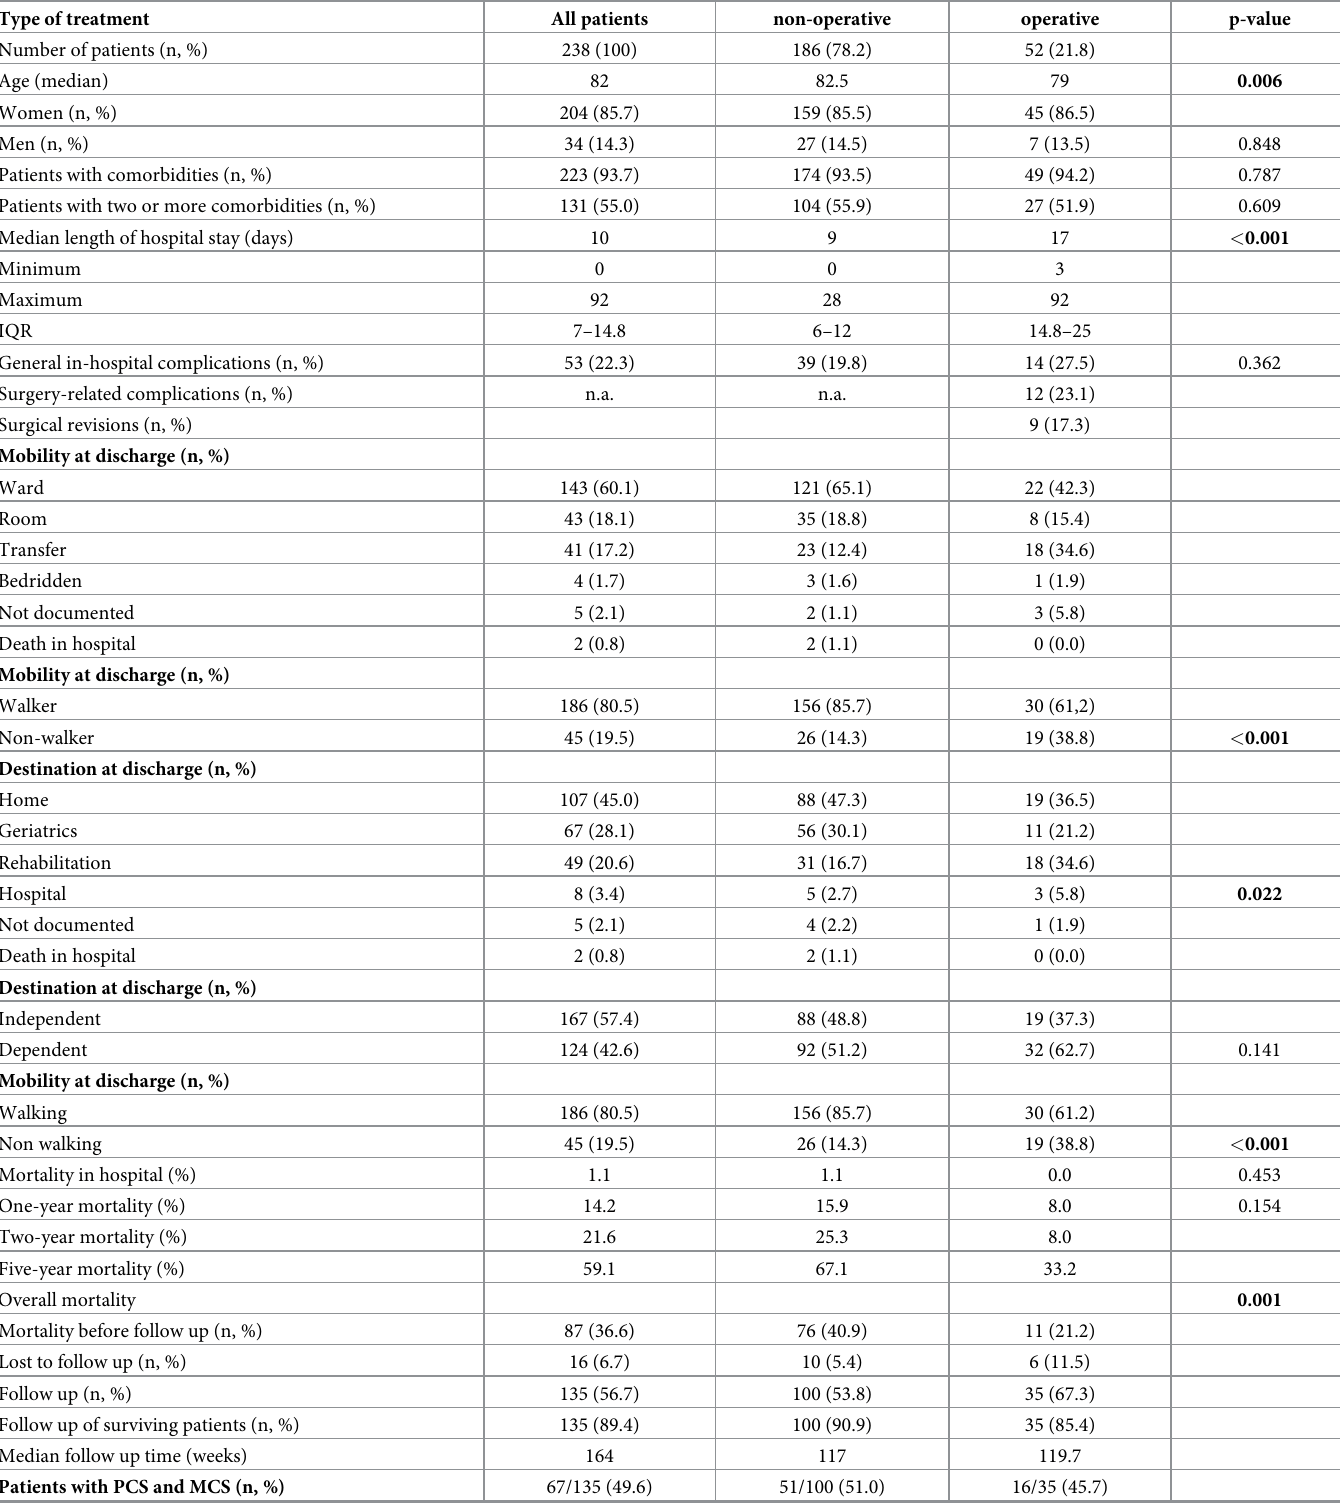
Table 7. Demographics, LoS, mortality, situation at discharge and at follow up of FFP type III and FFP type IV patients, depending on type of